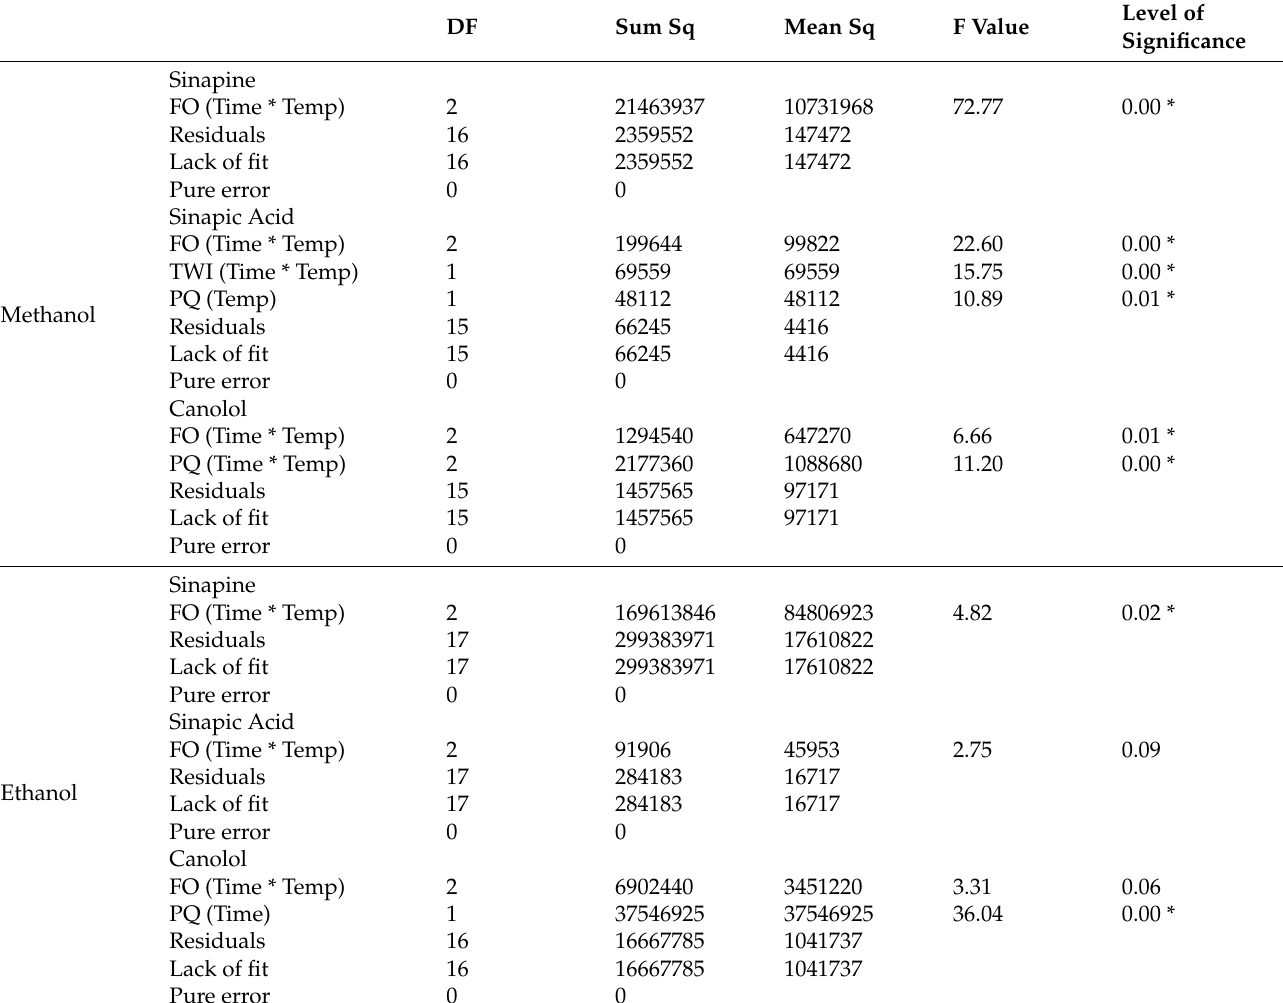
Table 3. Analysis of variance (ANOVA) table for the major sinapates. DF Sum Sq Mean Sq F Value